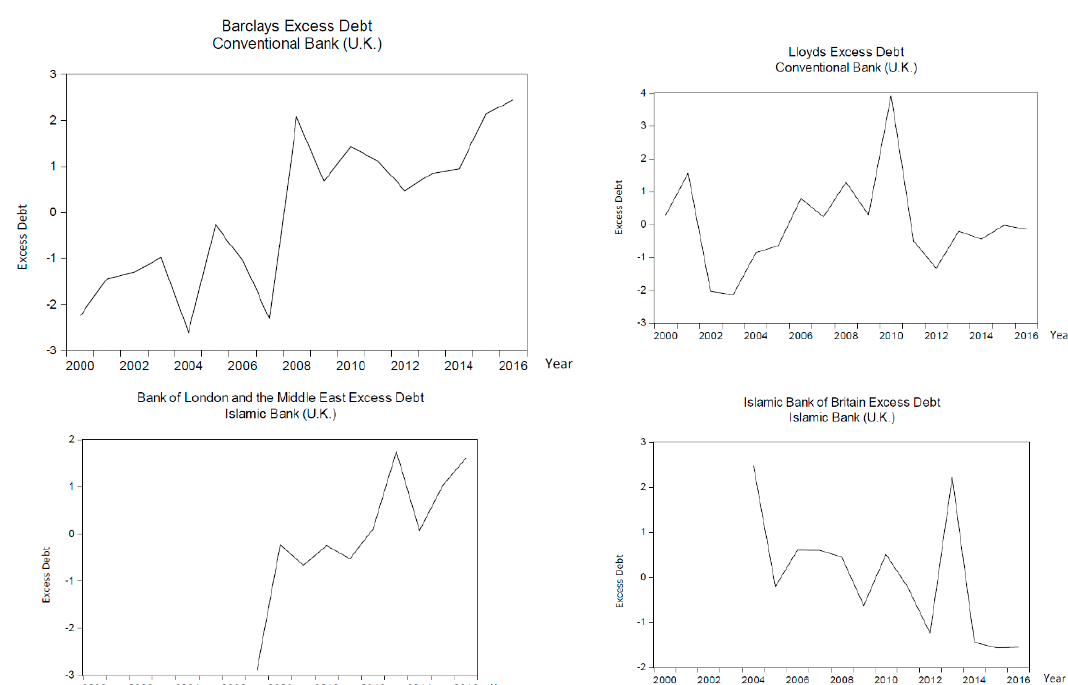
Figure 10. United Kingdom excess debt. Source: Author’s calculations.